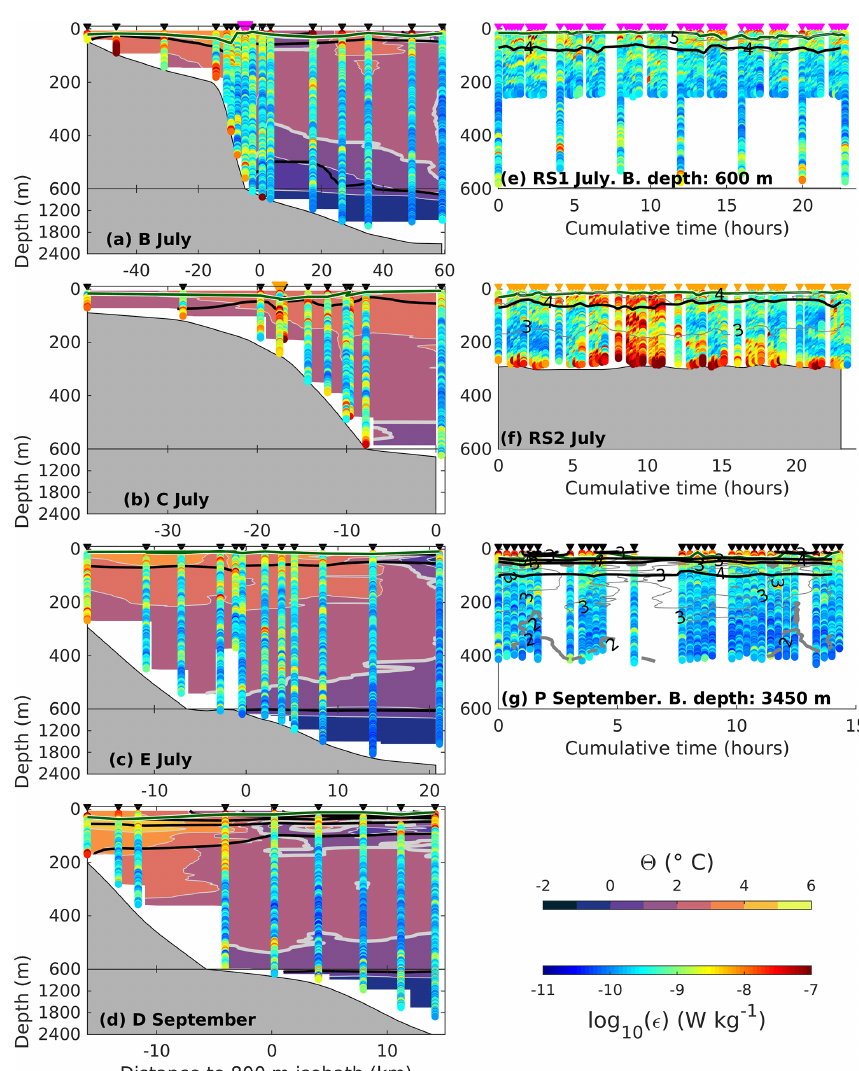
Figure 3. Overview of the main sections (a–d) and the process study stations (e–g) during the July and September cruises. In (a) – (d) , back- ground is (cid:50) , and the dissipation rate profiles ( (cid:15) ) are superimposed. Note the change of vertical scale at 600m depth. In (e) – (g) , temperature contours are shown as thin grey lines. In all panels, bold black lines are the isopycnals, and the thicker grey line is the 2 ◦ C isotherm. Bathymetry is from the bottom depth measured at each station. Triangle markers are the time or location of the stations. In (a) and (b) , the pink and orange station markers indicate the location of the RS1 and RS2 process station, respectively, shown in (e) and (f) . At station P (g) , one early VMP cast performed about 6h before the start of the first shown profile is excluded. The horizontal axis is the distance to the 800m isobath in the (a) – (d) and cumulative time from the first profile in (e) – (g) . The dark green line is the mixed layer